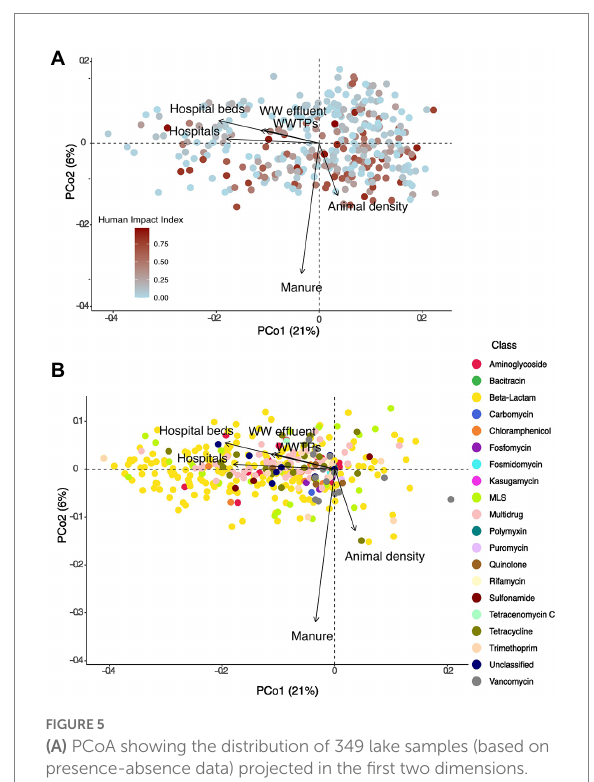
FIGURE 5 (A) PCoA showing the distribution of 349 lake samples (based on presence-absence data) projected in the first two dimensions. Each sample is colored by its HII. Arrows show variables that significantly correlated with the ordination after environmental fitting. (B) PCoA showing the distribution of individual resistance genes (based on presence-absence data) projected in the first two dimensions. Each resistance gene is colored by its class. Arrows show variables that significantly correlated with the ordination after environmental